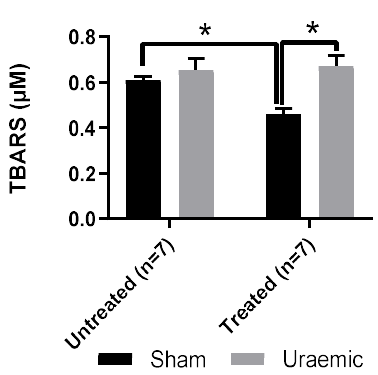
Figure 6. Serum TBARS. TBARS (thiobarbuturic acid reactive substances) were measured to access lipid peroxidation in uraemic and sham animals. Results are presented as mean ± SEM. (* p < 0.01).